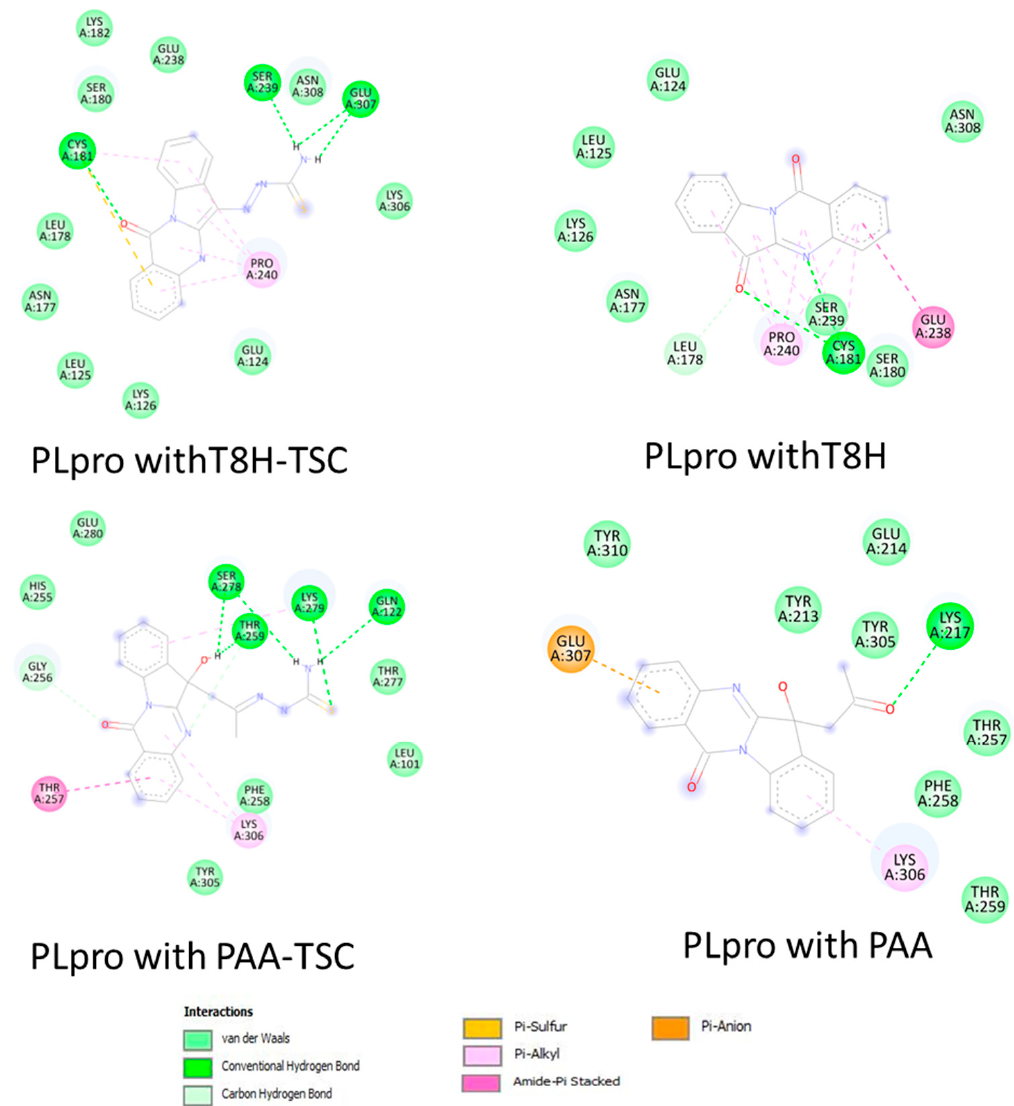
Figure 13. Comparison of 2D diagrams of interaction complexes PLpro with traptanthrin derivates (TSC compounds) ( left ) with tryptanthrin and PAA ( right ).